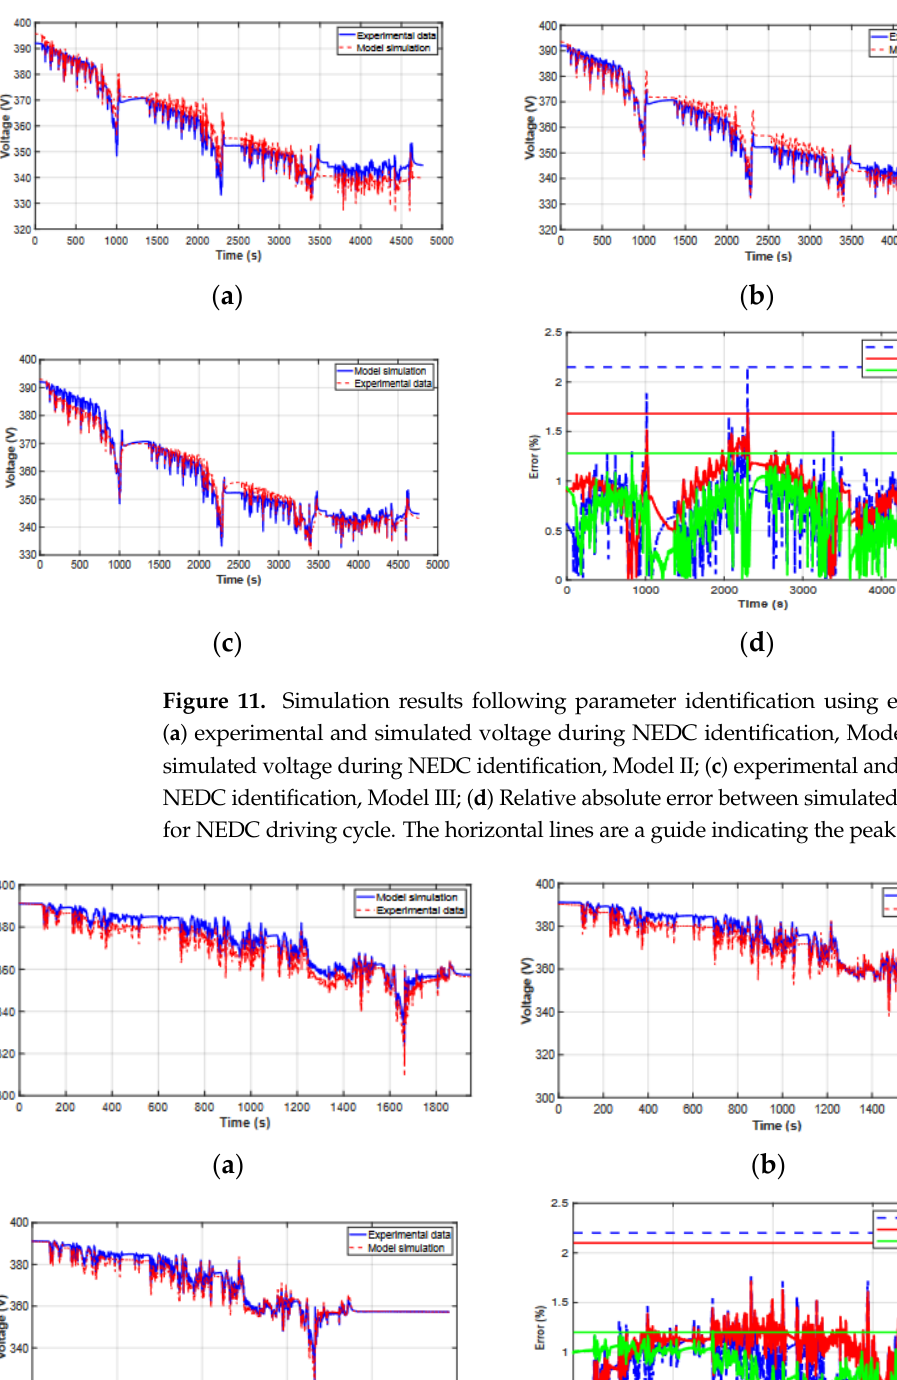
Figure 10. WLTC battery current profile from data recorded on chassis dynamometer.